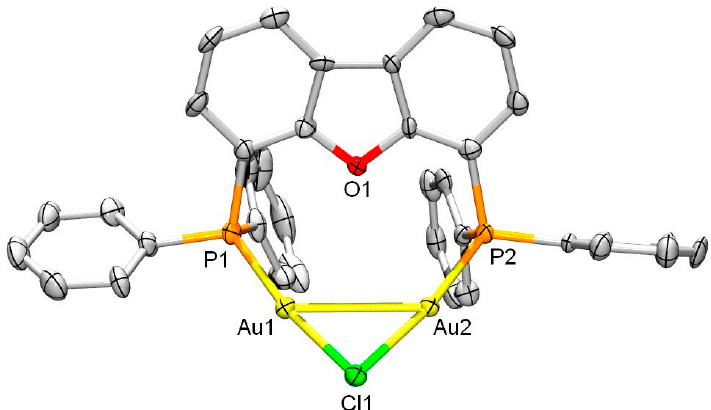
Figure 3. Displacement ellipsoid plot (50% probability level) of one of the two crystallographically independent cationic parts of 3 . The SbF 6 counterion and hydrogen atoms have been omitted for clarity. Selected bond lengths (Å) and angles ( ◦ ) (only given for the Au1–Au2 cationic part):